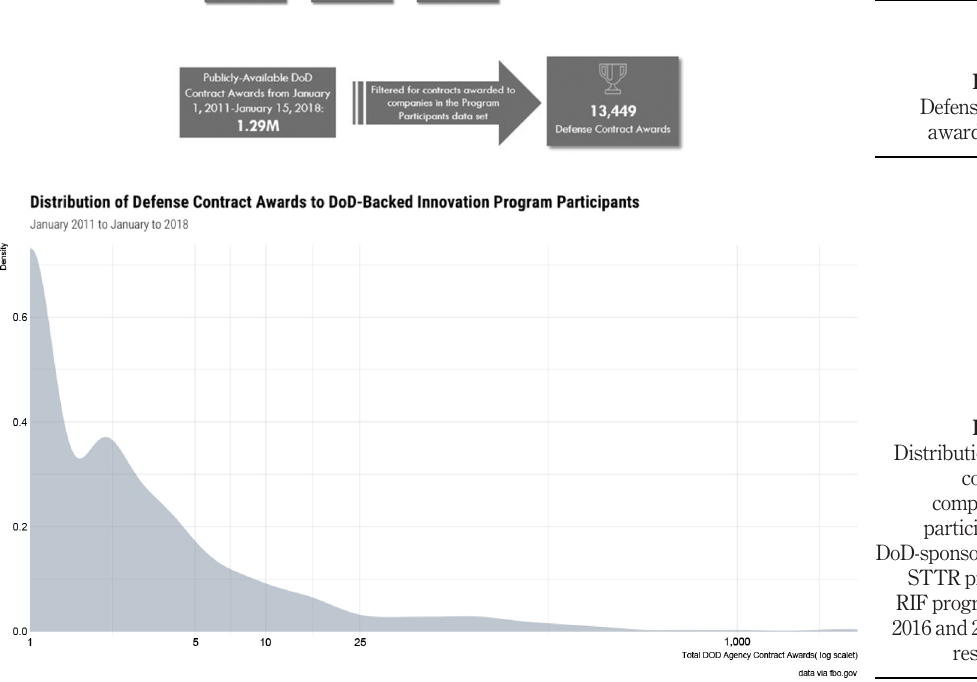
Figure 3. Defense contract